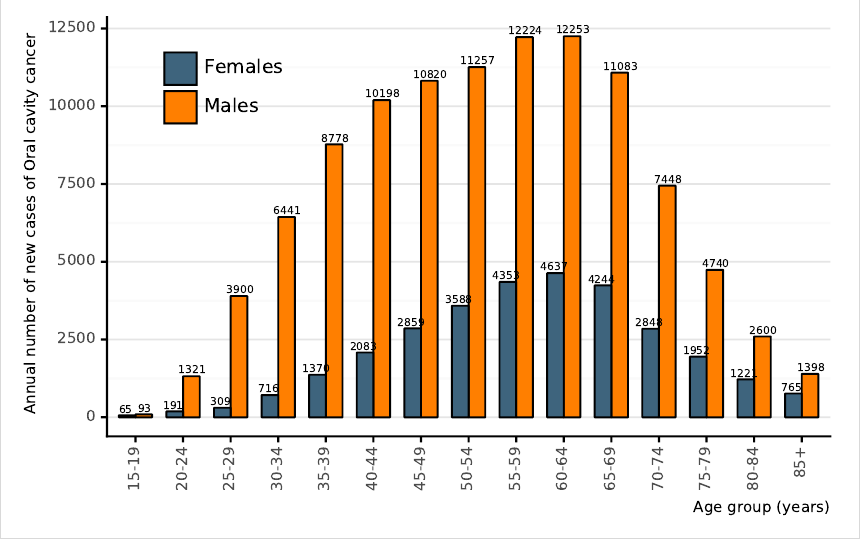
Figure 43: Annual number of new cases of oral cavity cancer in India (estimates for